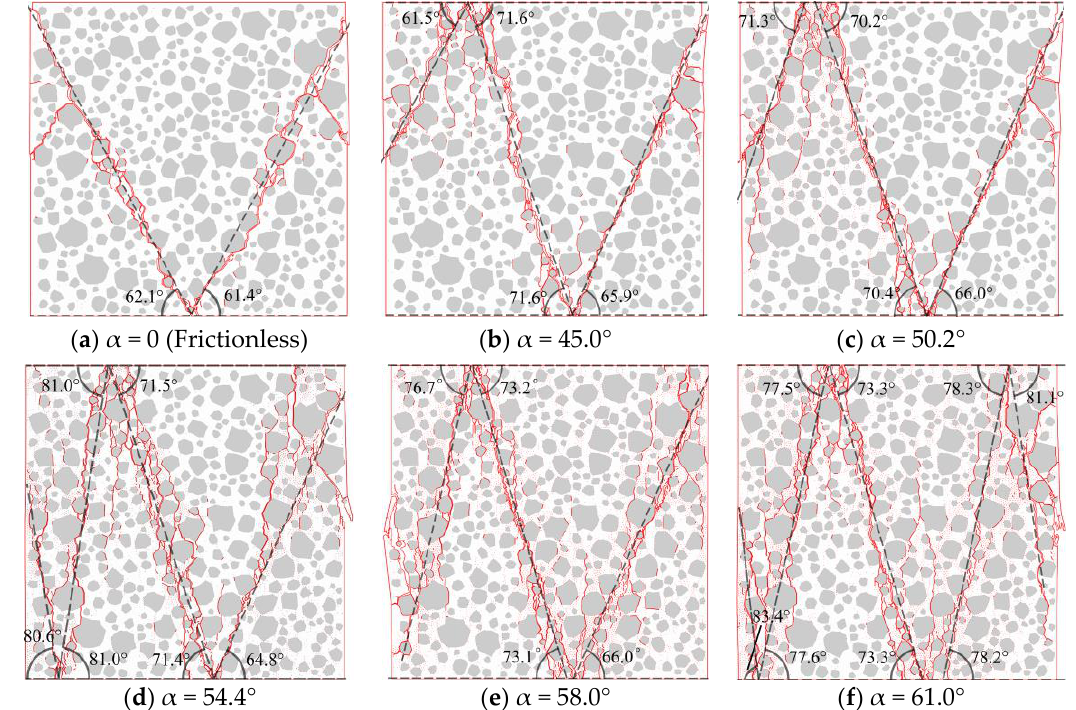
Figure 18. Failure modes of a specimen under the different frictional angles.